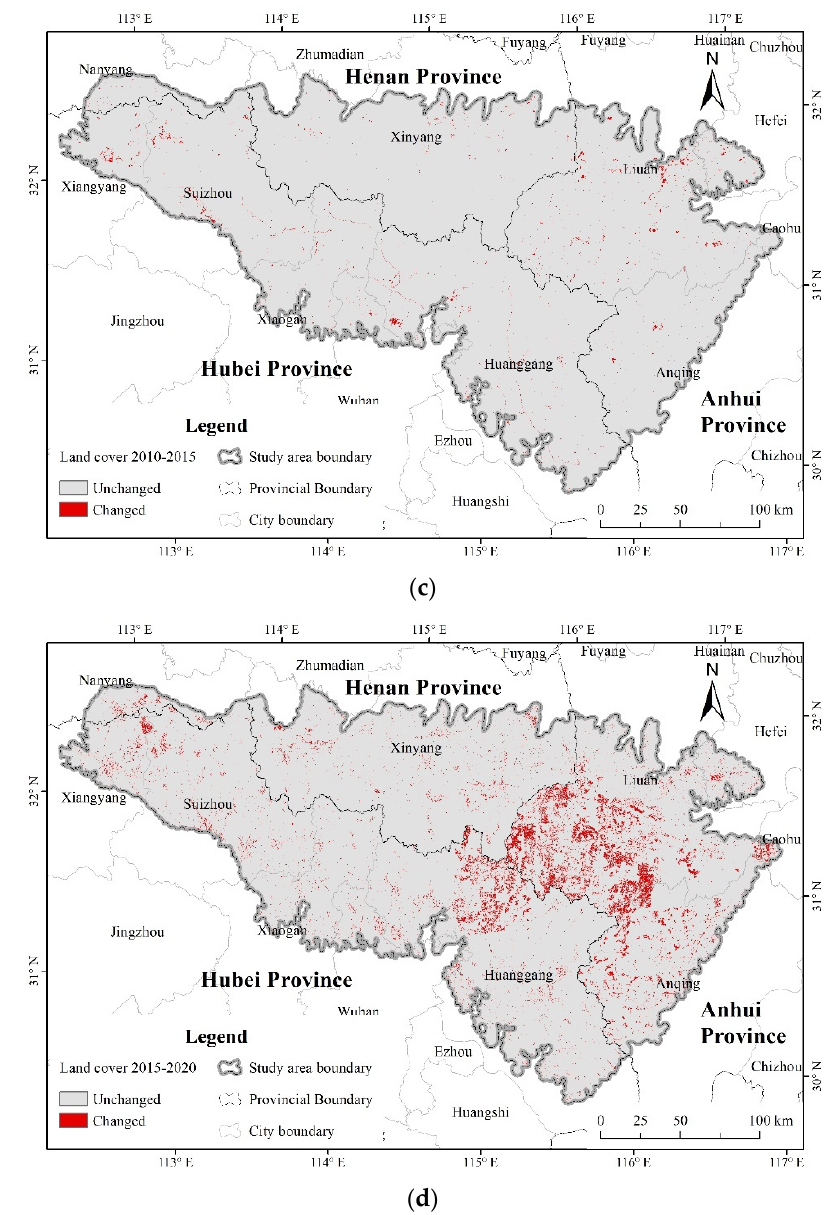
Figure 5. Interannual variation in ESV and land cover in the study area: dynamic changes in ESV from ( a ) 2010 to 2015 and ( b ) 2015 to 2020; dynamic changes in land cover from ( c ) 2010 to 2015 and ( d ) 2015 to 2020.